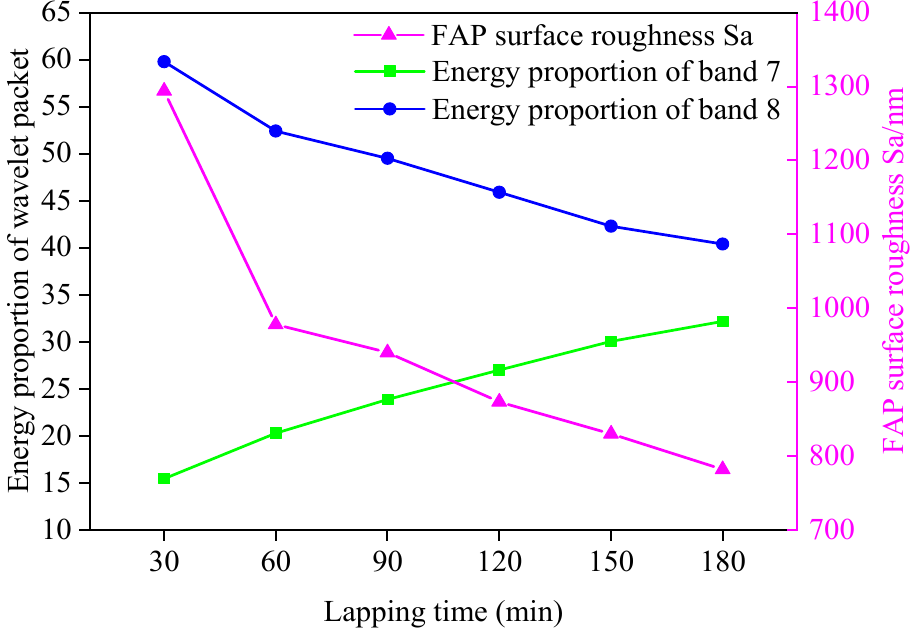
Figure 8. Relationship between surface roughness of the FAP and energy proportion of frequency bands 7 and 8.